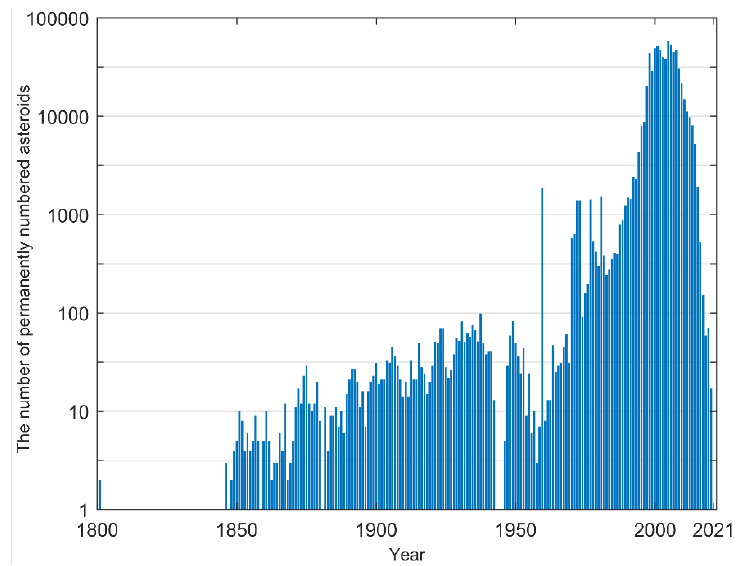
Figure 1. Statistics on the year of discovery of permanently numbered asteroids.